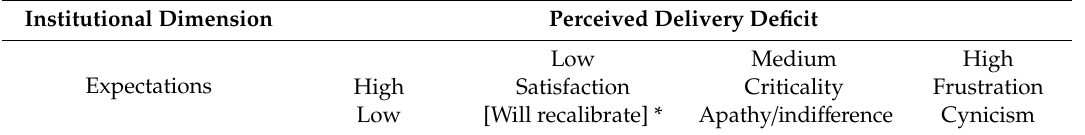
Table 1. Conceptual model of democratic frustration: An interaction between expectations and perceived delivery